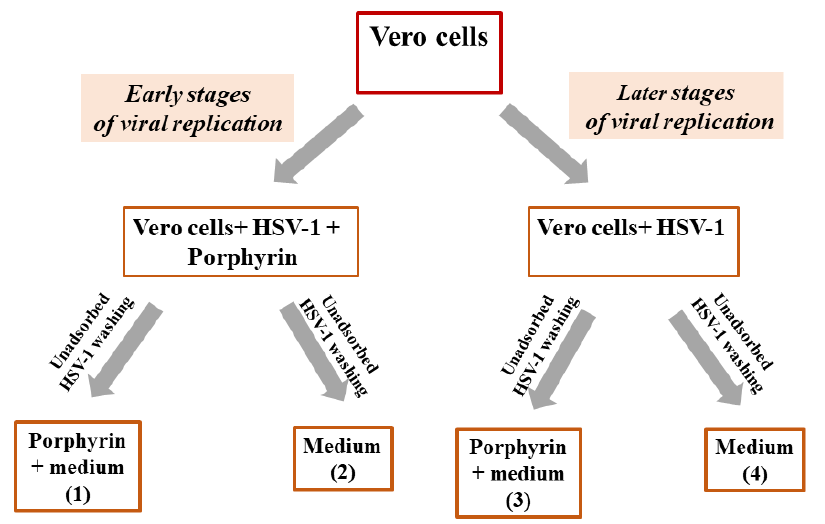
Figure 6. Experiment by the test compounds evaluation on the early or late stages of HSV-1 repli-